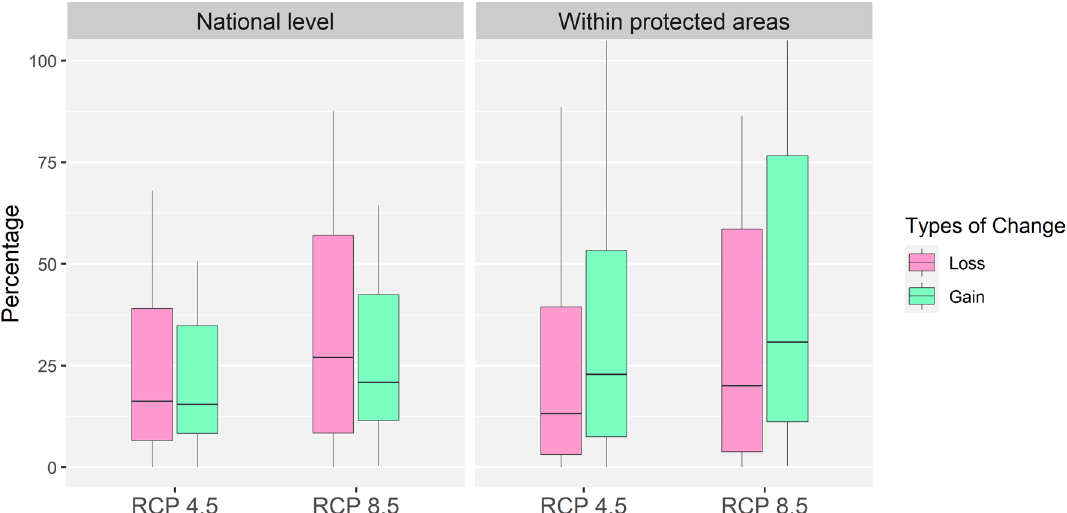
Figure 2. Percentage of suitable habitat loss (red) and gain (green) from climate change, relative to current predictions with LCC, for 19 dipterocarp species in the Philippines under two future climate scenarios (RCP 4.5 and RCP 8.5 for 2070), at the national level and within protected areas. The figure was created in R using the ggplot2 package 66,121